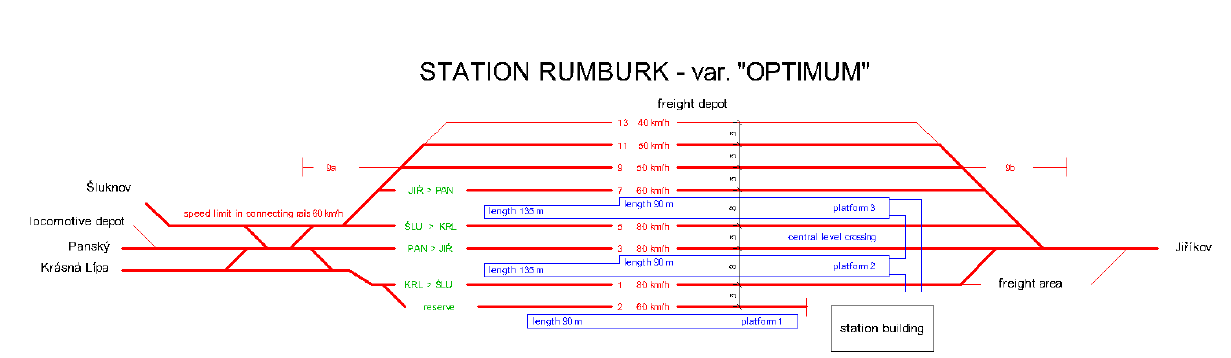
Figure 3. Optimal variant of modifications of the railway station Rumburk.